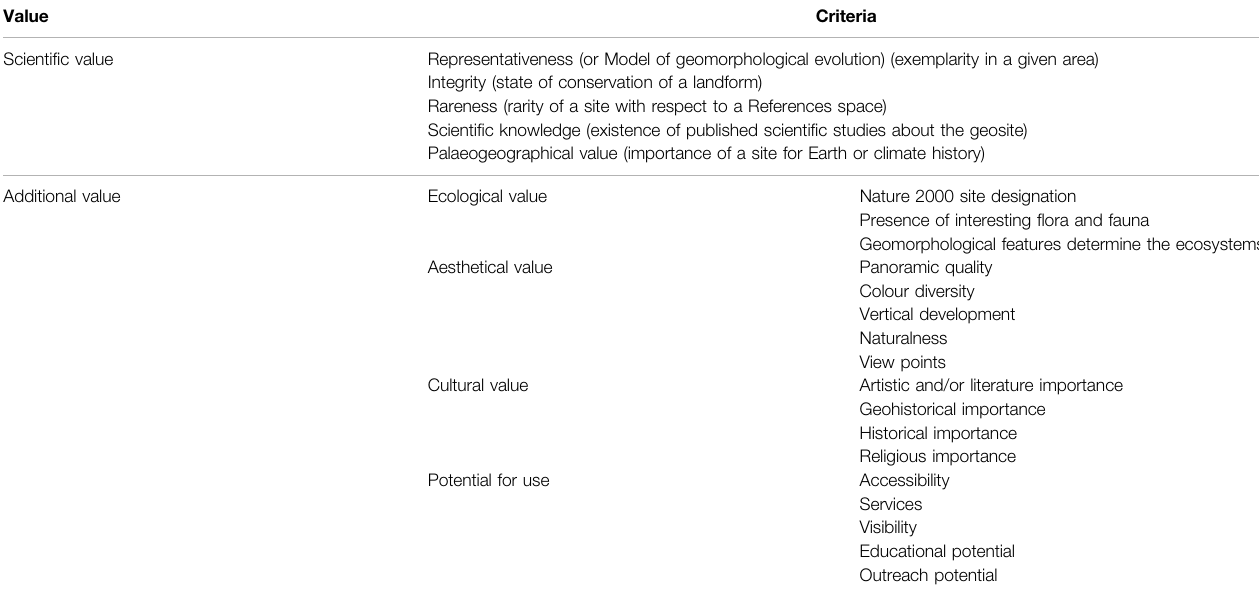
TABLE 1 | The criteria and image.png indicators to assess the de fi nition of the main values for the identi fi cation of a landform as geomorphosite.